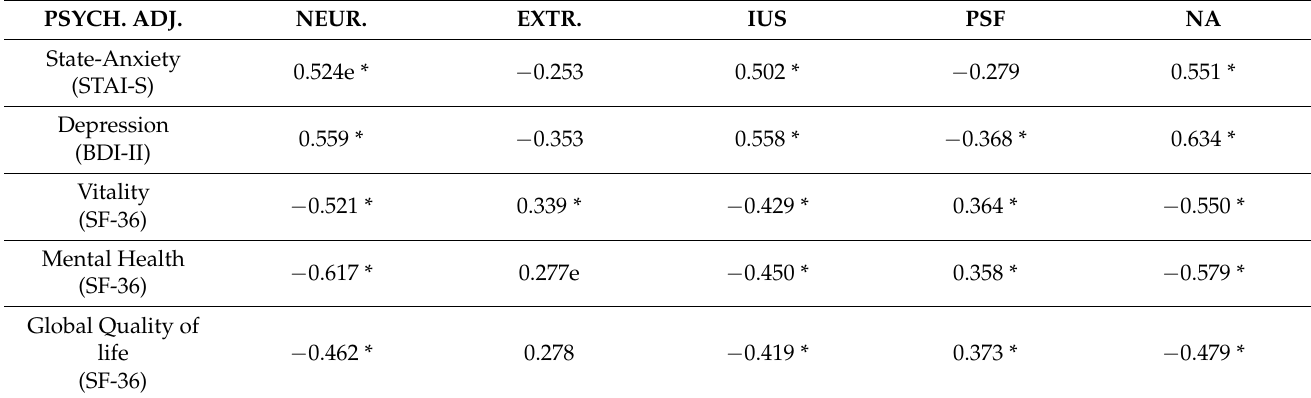
Table 1. Spearman correlation coefficients (r s ) for the mean of the psychological adjustment variables that significantly worsened during the lockdown and the individual dispositional